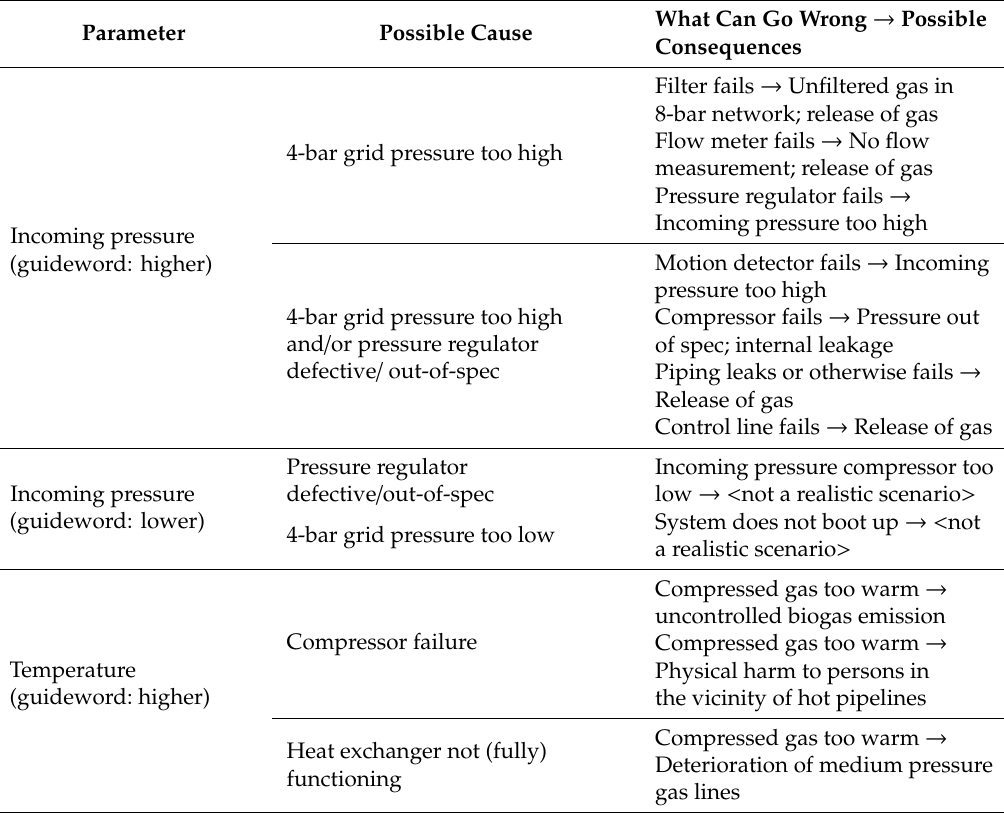
Table 4. Detailed excerpt from